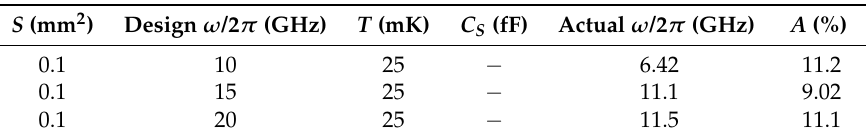
Table 3. Qubit designs with no series capacitor S = 0.1 mm 2